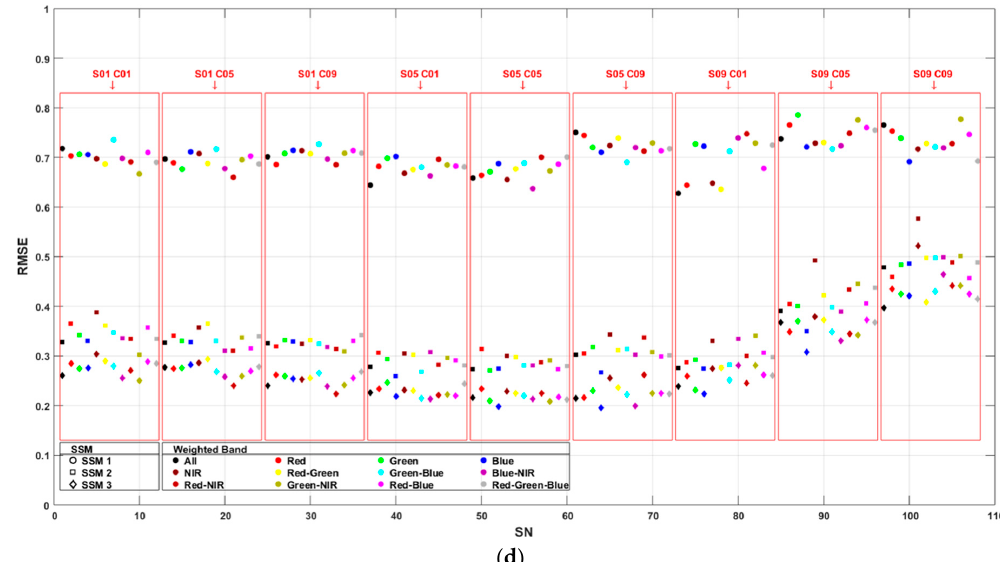
Figure 8. ( a ) Over segmentation, ( b ) area fit index, ( c ) 1-Quality rate, and ( d ) root mean square error of segmentations.